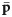
Calculation of the animal representation.(A) Example of the sliding window algorithm for points p¯ and q¯ with a window size of 5. Contour points with sharp angles are given in red. (B) Animal representation including the notation given in the text. (C) Body bending is calculated based on Eq (3). An animal is not bended if γ = 180°, bended to the left if γ > 180° and bended to the right if γ < 180°.